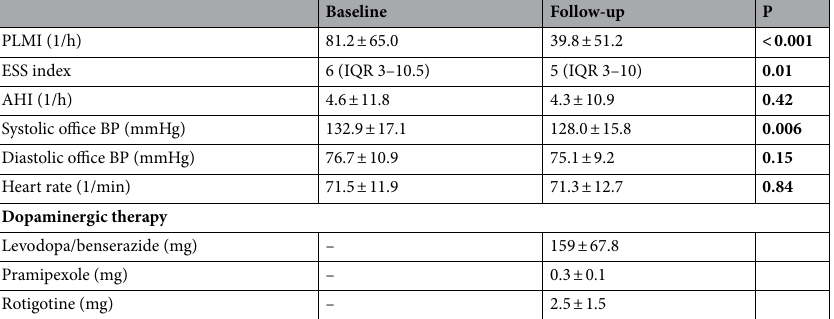
Table 2. Sleep disorder parameters and office blood pressure at baseline and follow-up. Numeric data were compared by two-tailed t tests, ordinal data (ESS) by the Wilxocon signed rank test. P < 0.05 was